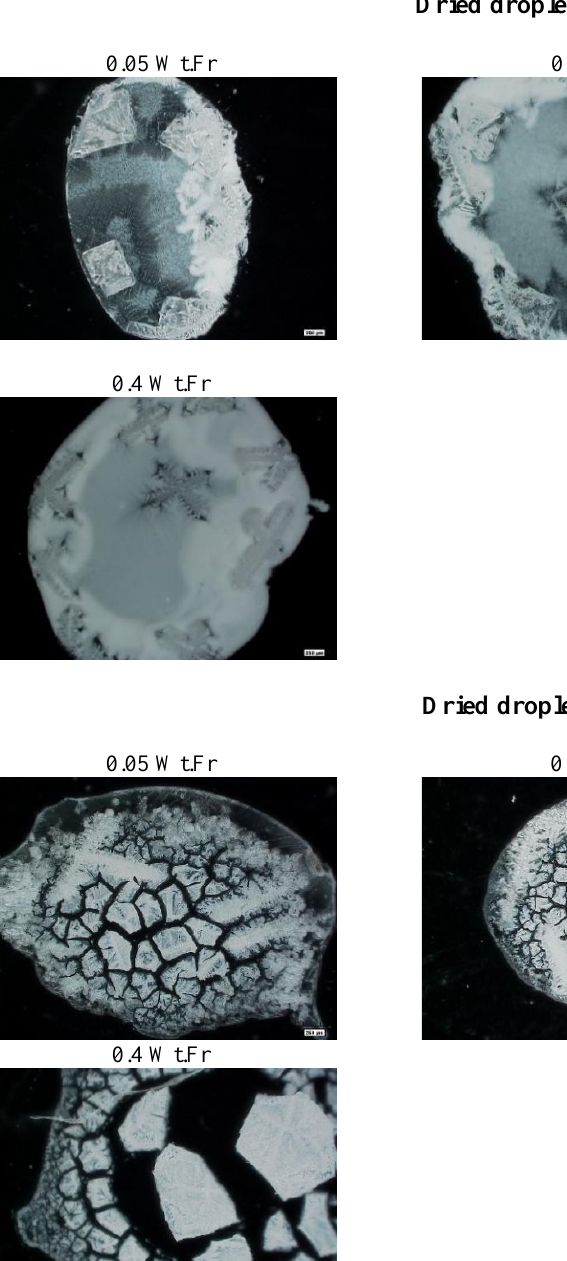
Figure 10—Dried droplets of Al but only in the first two in SiO for Al O but it is not so clear in SiO 2 3 bars in every frame is 250